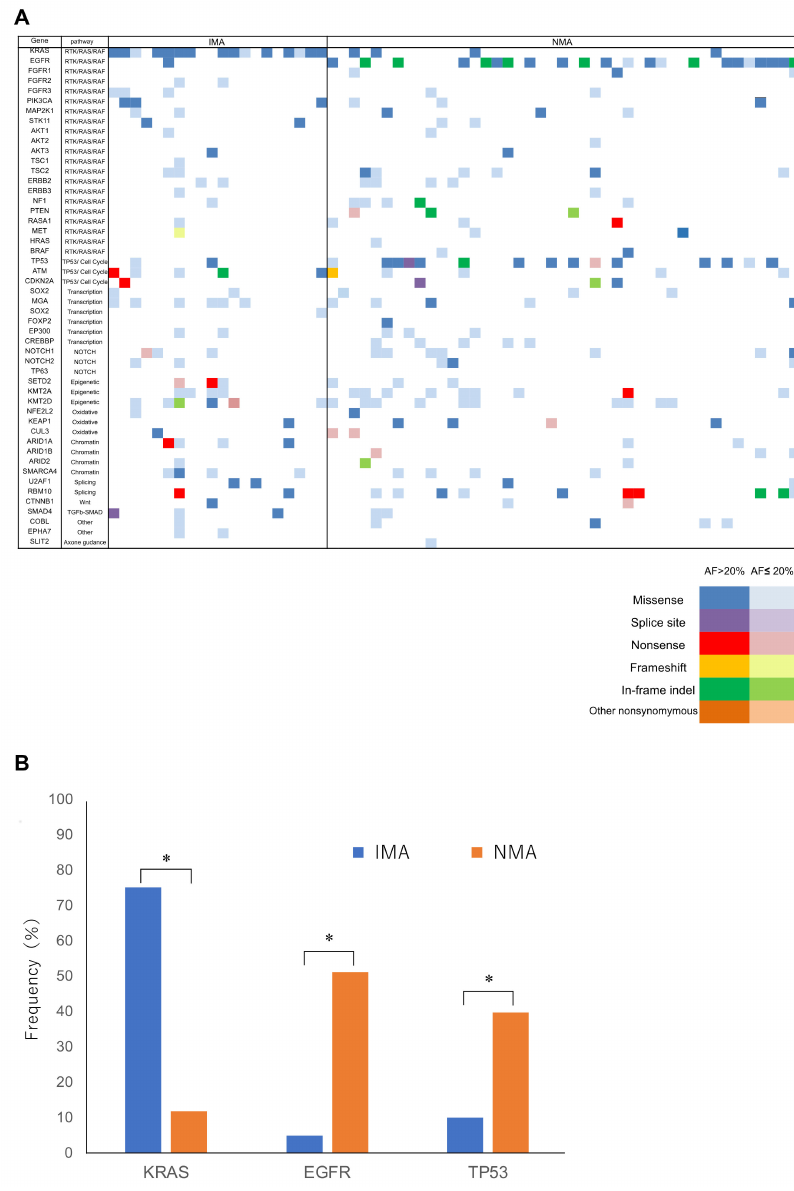
Figure 1. Mutational profile of invasive mucinous adenocarcinoma (IMA) and nonmucinous adenocarcinoma (NMA). ( A ) Most specimens harbored multiple mutations affecting several different functional pathways. However, the prevalence of Kirsten rat sarcoma viral oncogene homolog ( KRAS ), epidermal growth factor receptor ( EGFR ), and tumor protein p53 ( TP53 ) mutations was different between IMA and NMA. Nonsynonymous mutations are color-coded as indicated, with dark colors representing allele fractions >20%, and light colors representing allele fractions ≤ 20%. ( B ) KRAS mutations were significantly more frequent in IMA than in NMA. In contrast, mutations in EGFR and TP53 were significantly less frequent in IMA than in NMA. *, p <